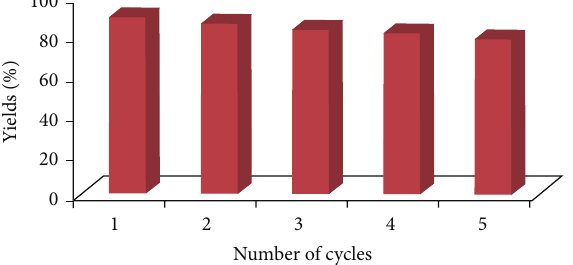
Figure 1: Recyclability of ZnO nanoparticles for the synthesis of 7 󸀠 -amino- 2 󸀠 2 󸀠 -dimethyl-2,4 󸀠 dioxo-1,2-dihydrospiro[indoline-3,5 󸀠 - pyrano[2,3-d][ 1 󸀠 , 3 󸀠 ]dioxine]-6 󸀠 -carbonitrile ( 4 a